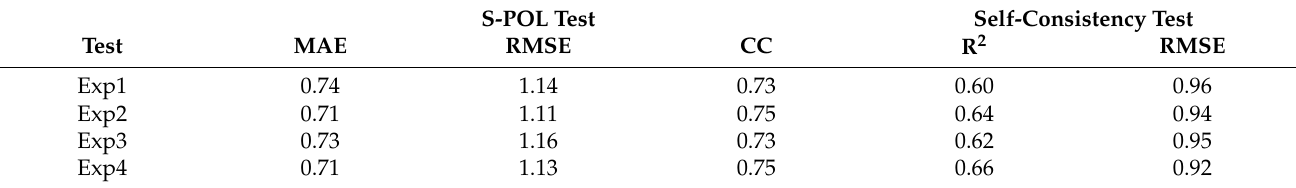
Table 2. Accuracy and error statistics of K DP obtained from four tests.